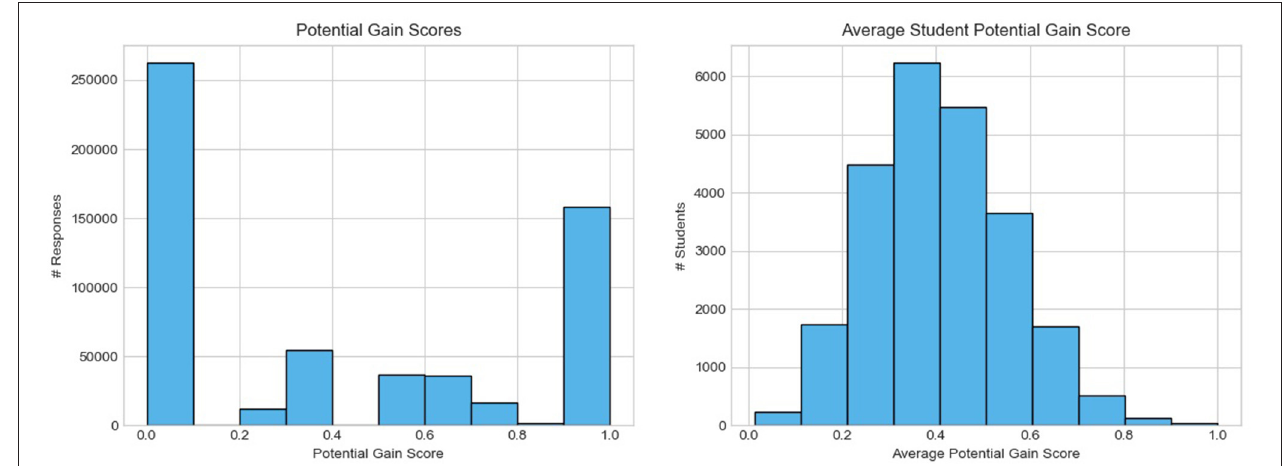
FIGURE 1 | Distribution of potential gain scores in the